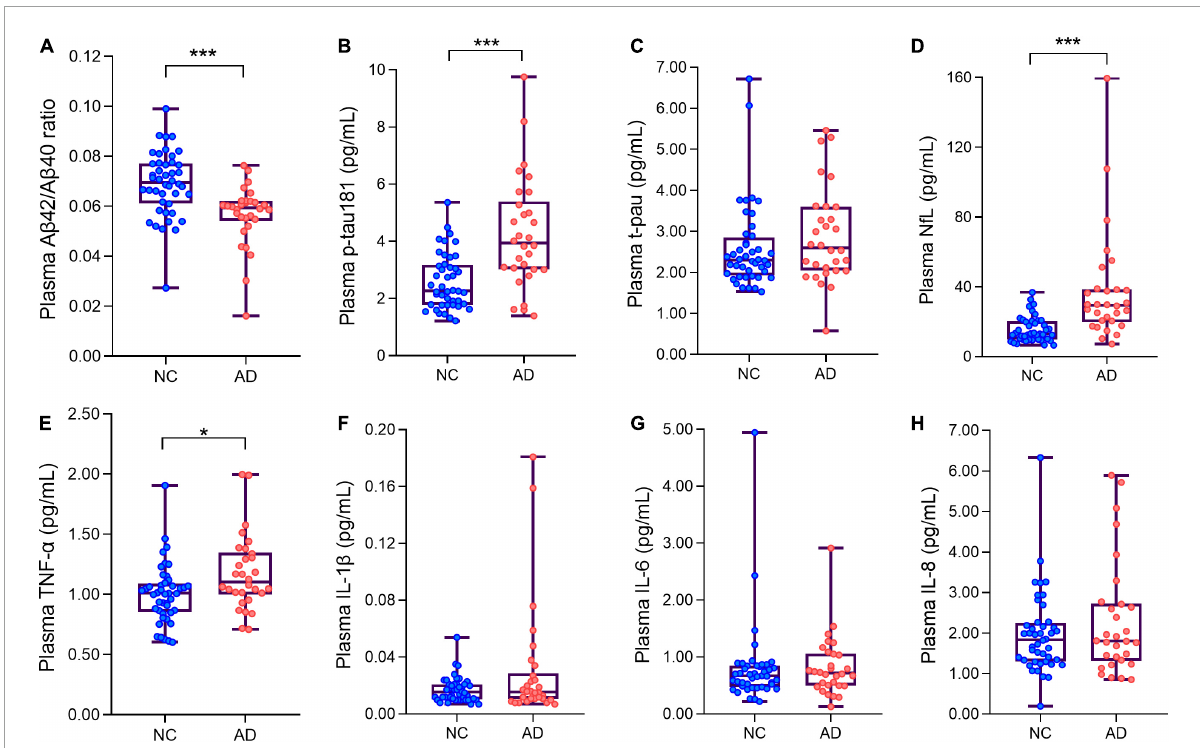
FIGURE1 Box plots showing the levels of plasma ANT biomarkers and inflammatory factors of AD patients and normal controls. (A) The levels of plasma A β 42/A β 40 ratio of AD patients and normal controls. (B) The levels of plasma p-tau181 of AD patients and normal controls. (C) The levels of plasma t-pau of AD patients and normal controls. (D) The levels of plasma neurofilament protein light chain (NfL) of AD patients and normal controls. (E–H) Four plasma inflammatory factors (TNF- α , IL-1 β , IL-6, IL-8) levels in AD and NC groups. * p < 0.05,*** p < 0.001 compared with the normal group. Boxes show interquartile range, the horizontal lines are medians. AD, Alzheimer’s diseases; NC, normal control; pg/ml,